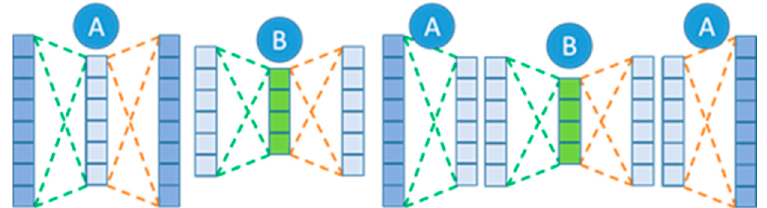
Figure 4. Stacked autoencoder (SAE) architecture, consisting of two single models trained separately, in which the hidden layer of model A being the input layer of model B. To the right, the model is shown in full (A-B-A).